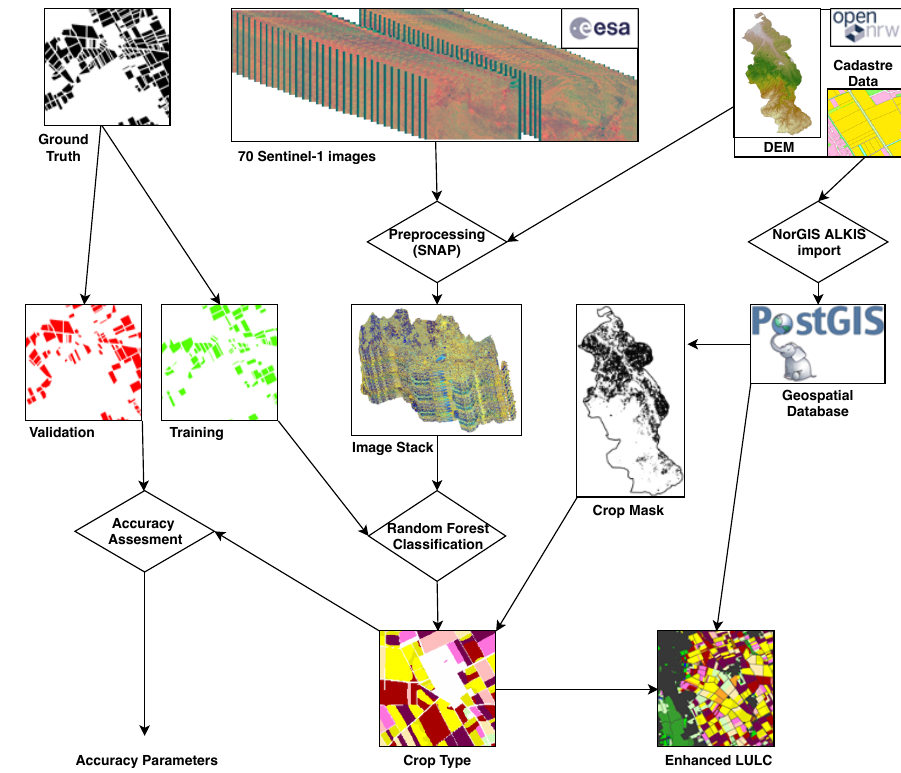
Figure 2. Flowchart of the data flows and processing steps of this